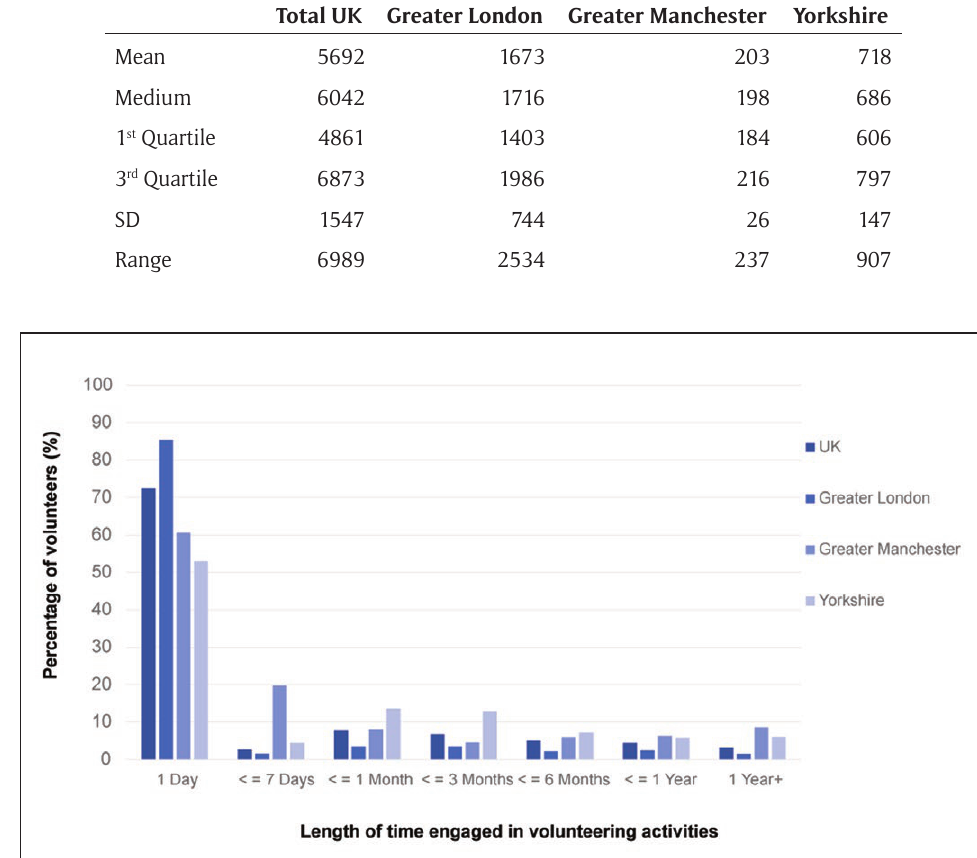
Table 1: TCV’s annual volunteer numbers between years 2010 to 2013 for each geographical area.